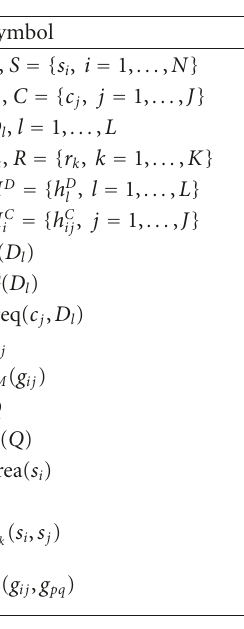
Table 2: Legend of main